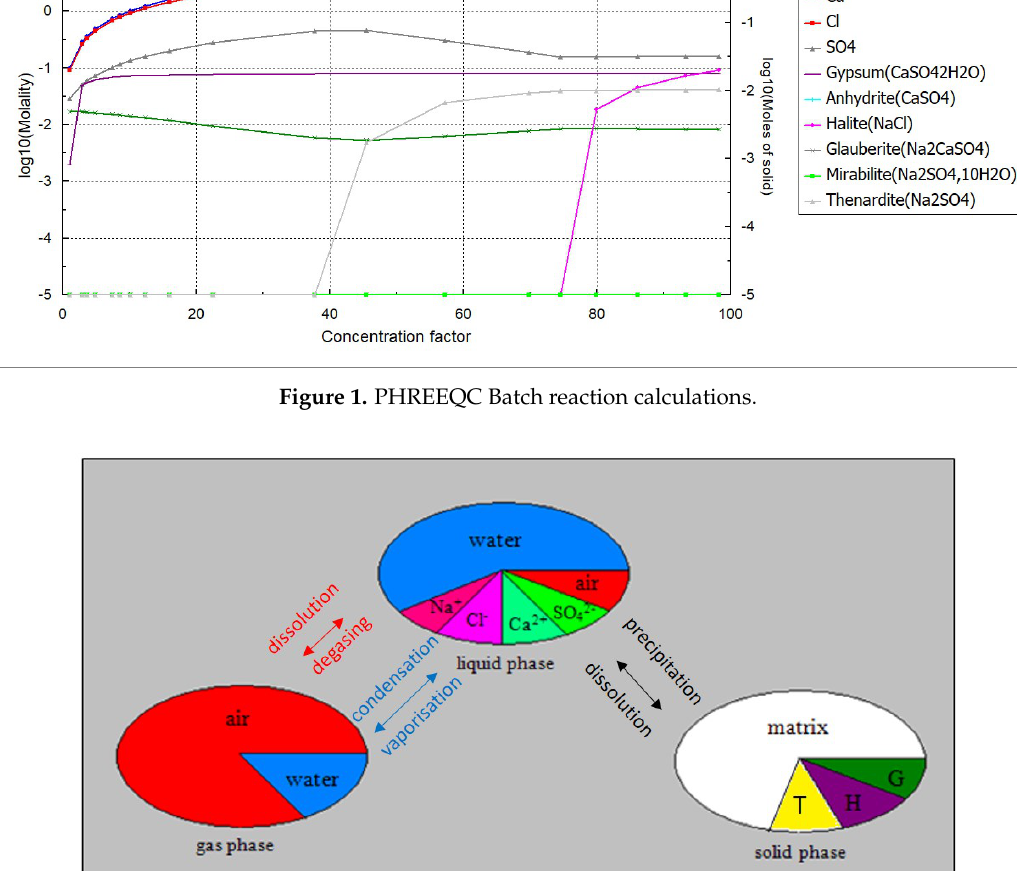
Figure 2. Three-phase (solid, liquid and gas)—multiple components porous medium model. The liquid phase consists of dissolved air and ionic species ( Na + − Ca 2 + − Cl − − SO 2 − dissolved ions between liquid and solid phase through precipitation and formation of Gypsum (G), Halite (H) and Thenardite